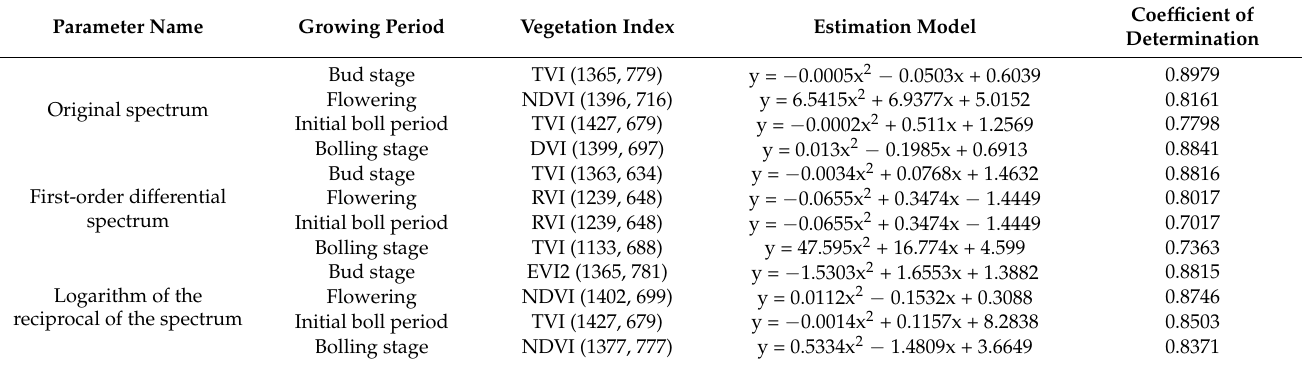
Table 4. Construction of the model to estimate the LAI in different growth stages of cotton.